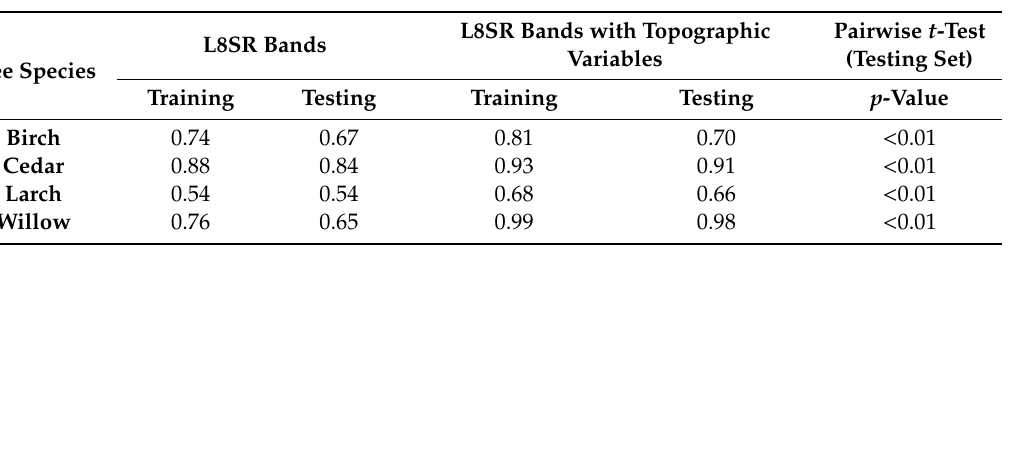
Table 4. Reported average AUC values for the training set and testing